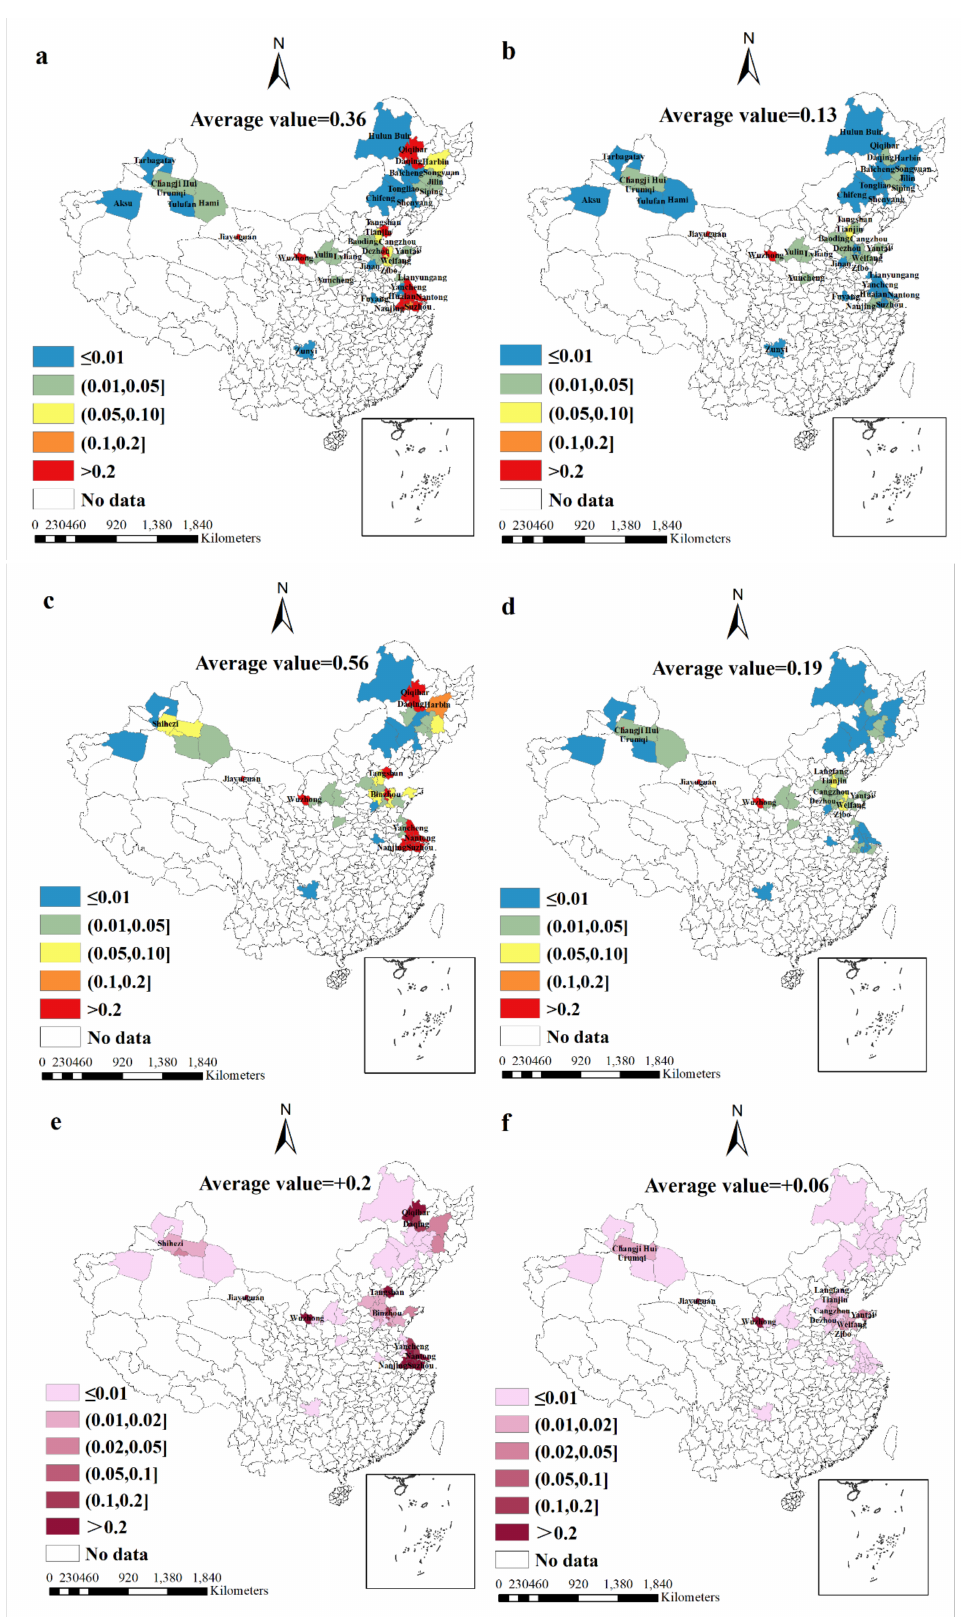
Figure 5. Withdrawal- and consumption-based water stress index levels under 2 ◦ C scenarios in China in 2018; ( a ) Withdrawal based water stress index levels without CCS. ( b )